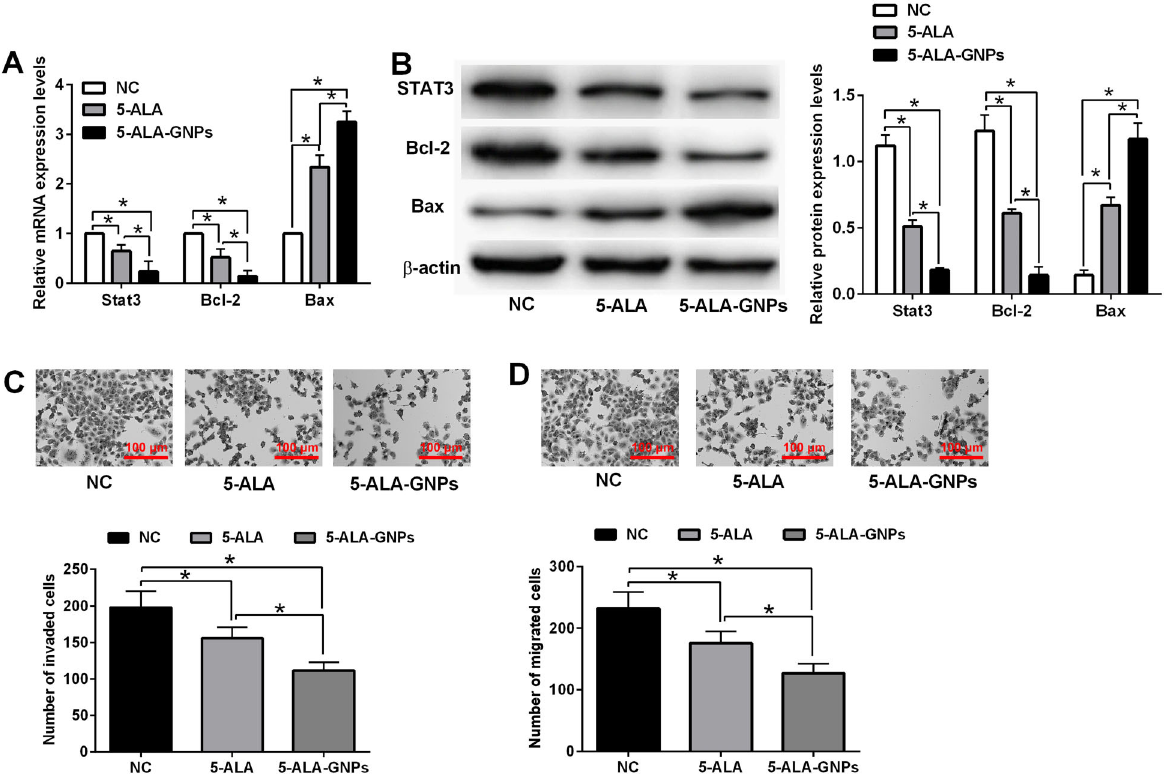
Figure 5. Effects of in vitro photodynamic therapy (PDT) on cell invasion and migration in A431 cells. A , The mRNA expression and ( B ) protein expression of STAT3, Bcl-2, and Bax in A431 cells after in vitro PDT with 5-aminolevulinic acid (5-ALA) (4 mM), 5-ALA-gold nanoparticles (GNPs) (8 mM), or phosphate-buffered saline (PBS (NC)) was determined by qRT-PCR assay (one-way ANOVA). C and D , Cell invasion and migration of A431 cells after the same treatment were determined by transwell invasion and migration assays, respectively. Scale bars, 100 m m. Data are reported as means ± SD (n=3). Signi fi cant differences between groups are indicated as *P o 0.05 (one-way